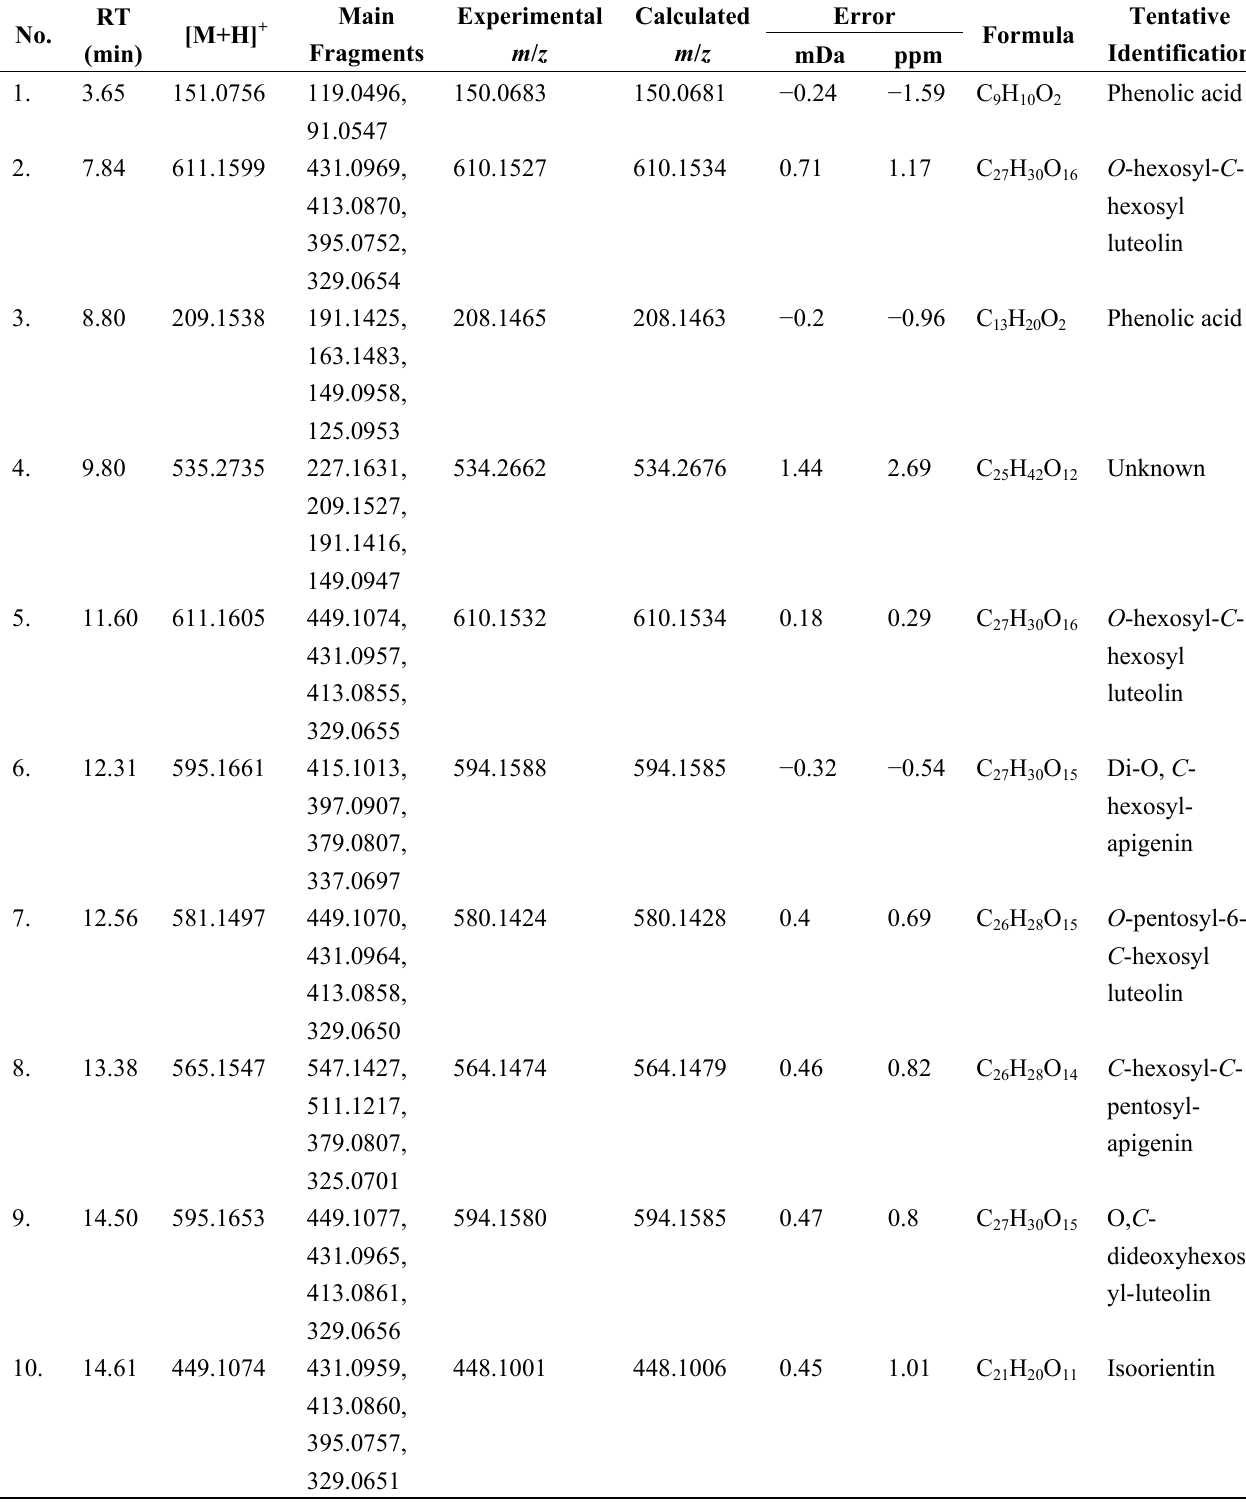
Table 1. MS data and the identification results of the constituents from B. textilis by LC-Q-TOF-MS.